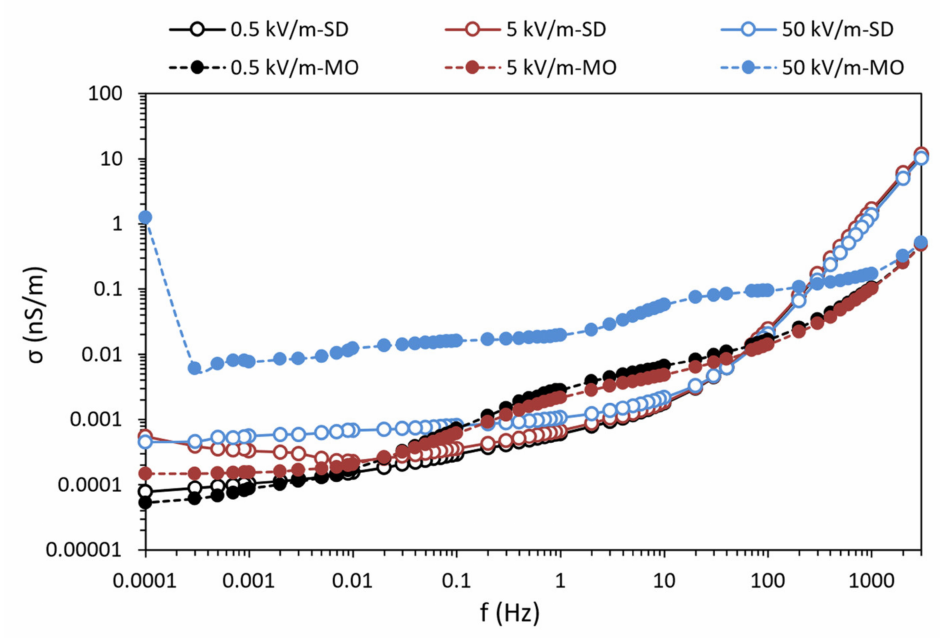
Figure 13. Frequency spectra of electrical conductivity σ of investigated oils at intensity E of the time-varying electric